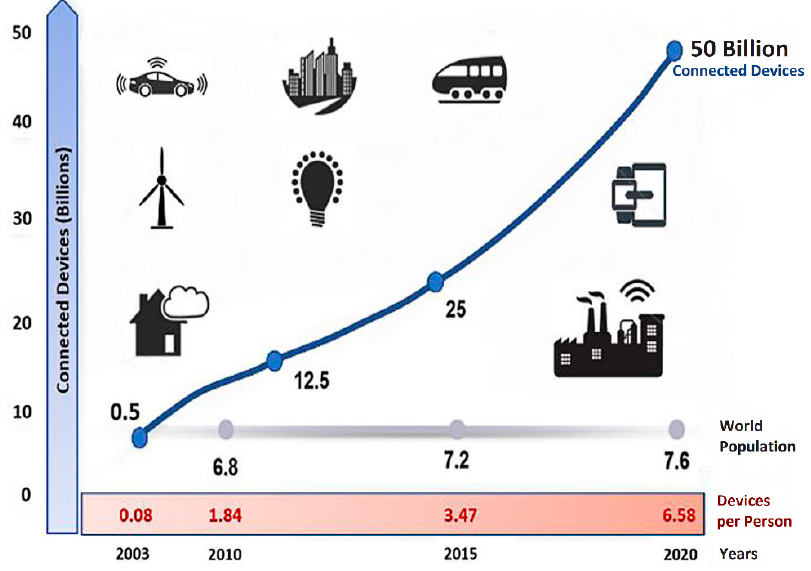
Figure 1. Future evolution of IoT devices.